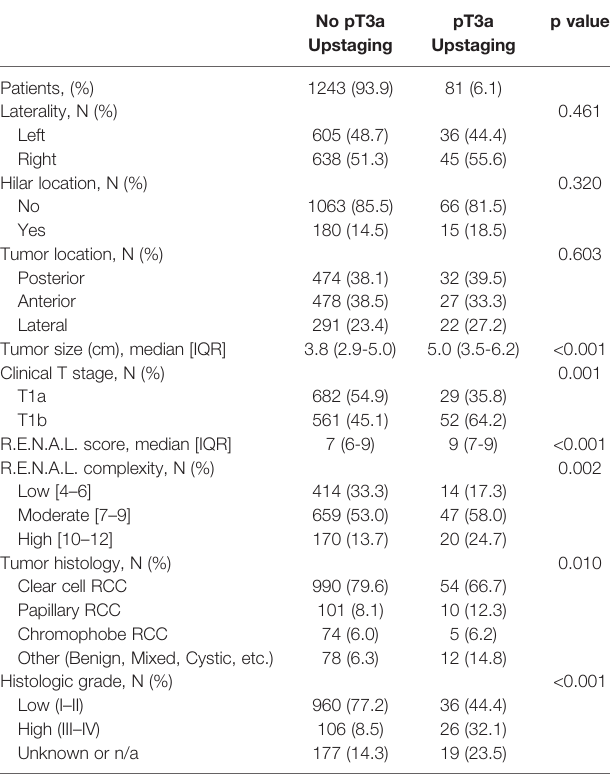
TABLE 2 | Tumor characteristics between those with and without pT3a renal cell carcinoma in study cohort.